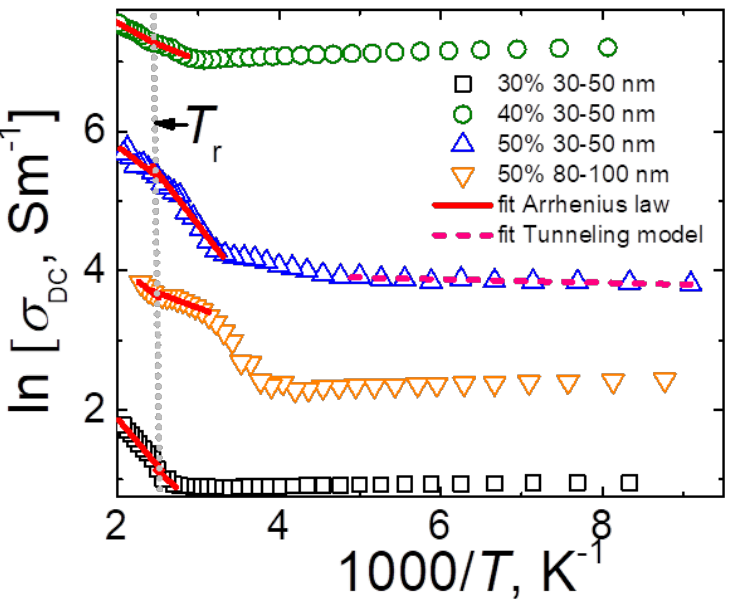
Figure 6. Inverse temperature dependence of DC conductivity for phosphate ceramics with Ag nanoinclusions. Table 2. Fit parameters of the temperature dependence of DC conductivity in different temperatures ranges.